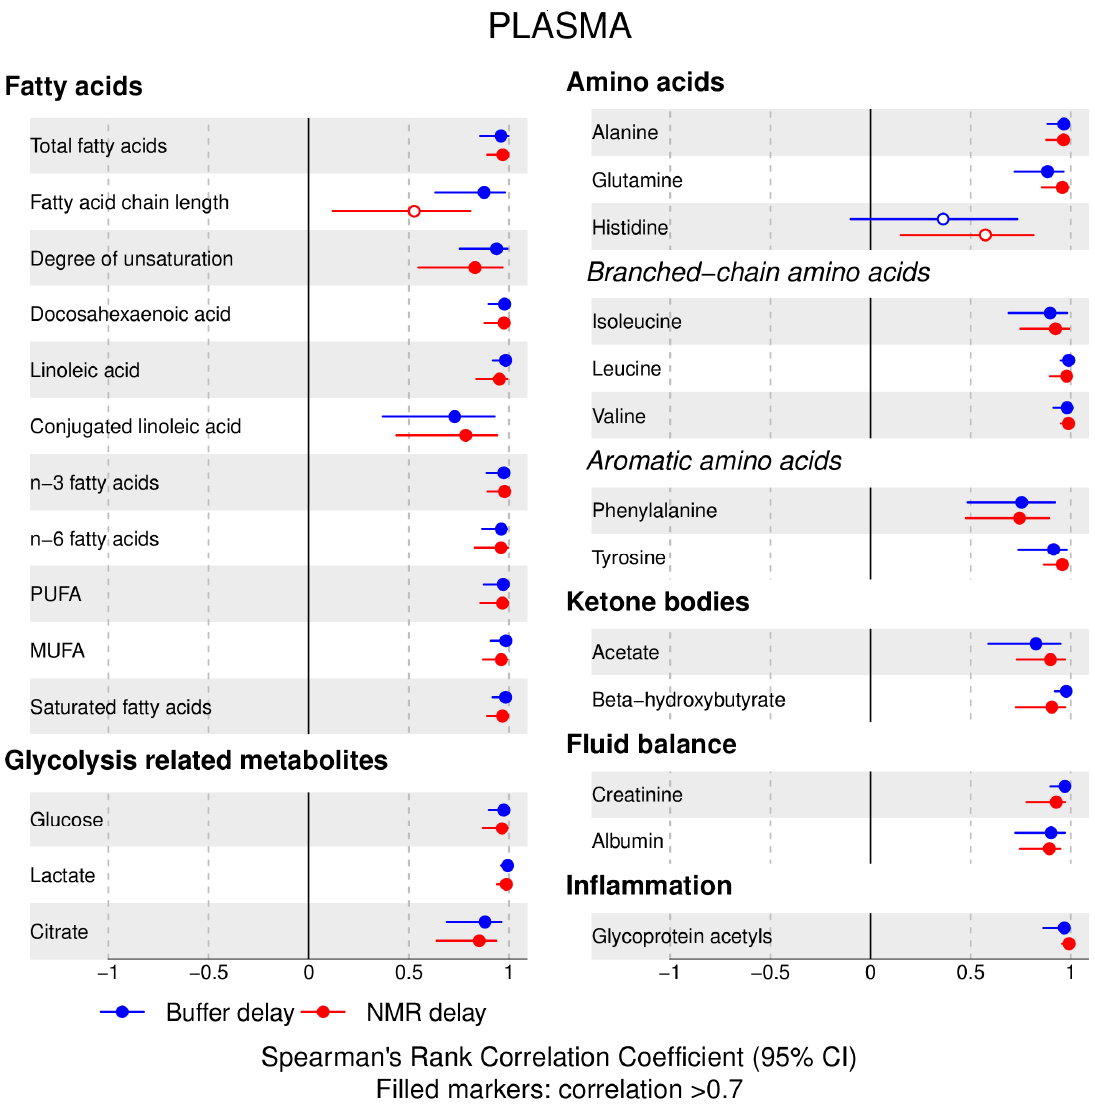
Figure 8. EDTA-plasma, post-storage handling effects (Figure 7 continued): Spearman’s rank correlation coefficients between metabolic trait concentration/value in reference samples (no sample preparation or nuclear magnetic resonance (NMR) analysis delays) and samples subjected to two variant post-storage conditions in which samples thawed overnight and afterwards (i) were left for 24 h before addition of sodium buffer followed by immediate NMR analysis (buffer delay); and (ii) addition of sodium buffer, then left for 24 h before profiling (NMR delay) (correlations for lipoprotein trait details are given in Figure S4, Supplementary Materials). Spearman’s rank correlation coefficients and 95% confidence intervals (CIs) are listed in Table S5, Supplementary Materials. MUFA, monounsaturated fatty acids; PUFA, polyunsaturated fatty acids.